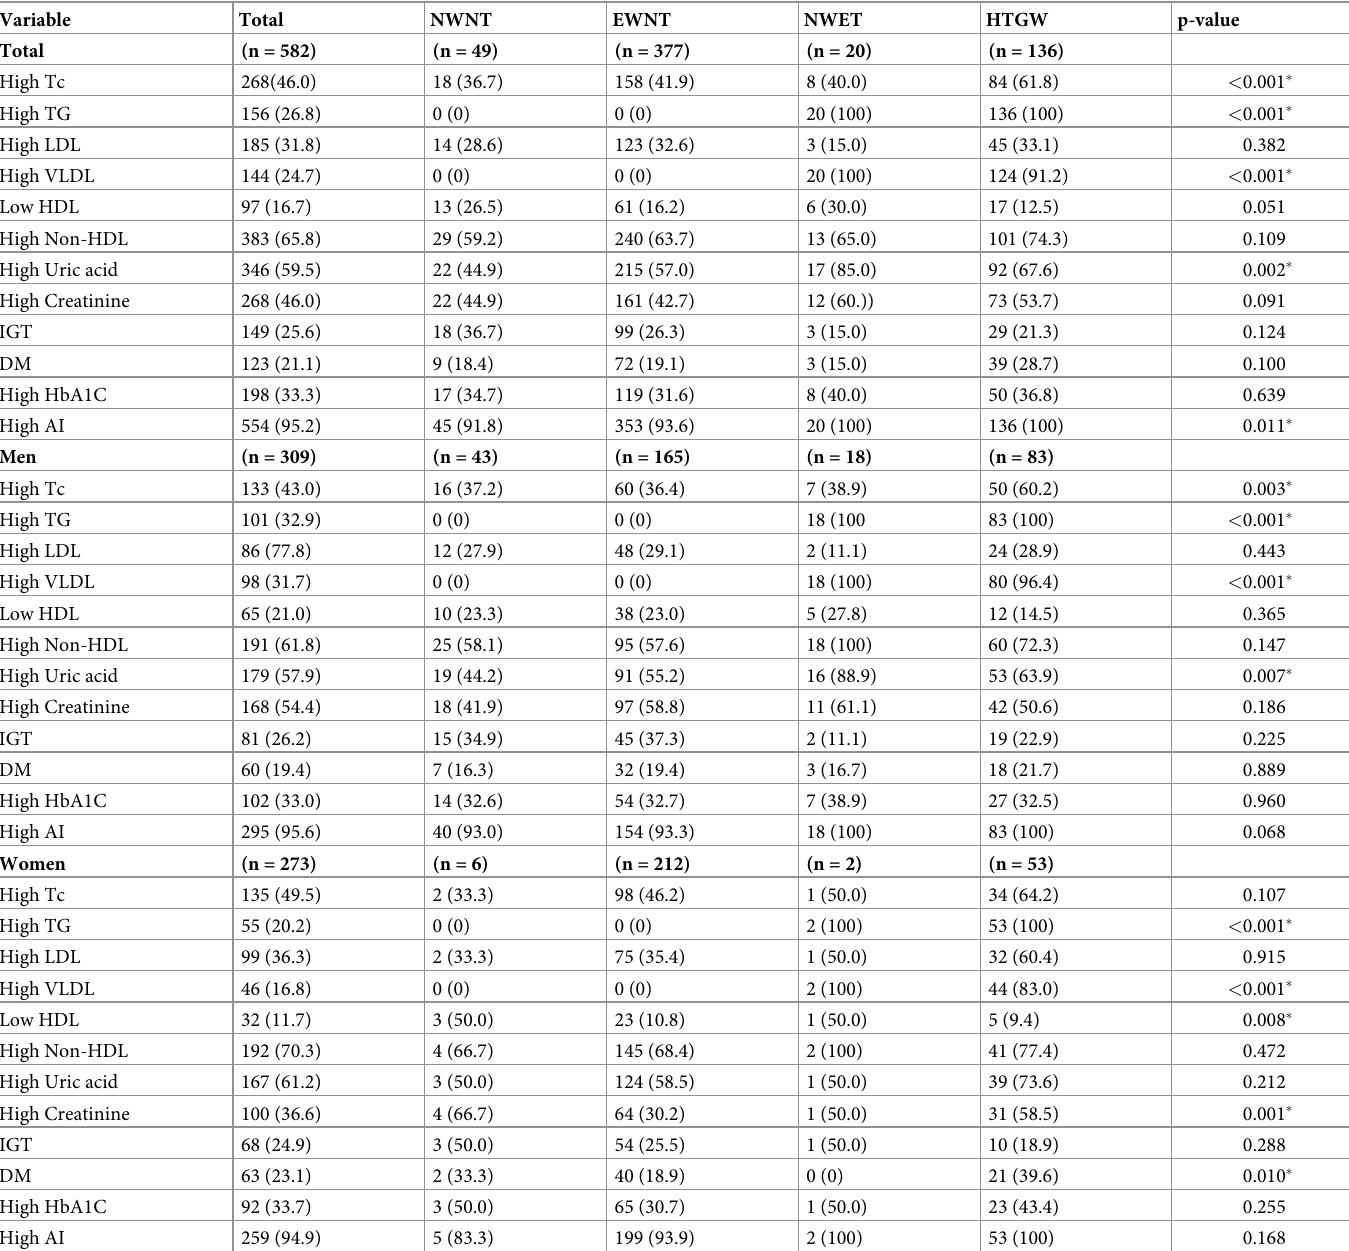
Table 3. Prevalence of metabolic abnormalities in the hypertensive triglyceridemic-waist